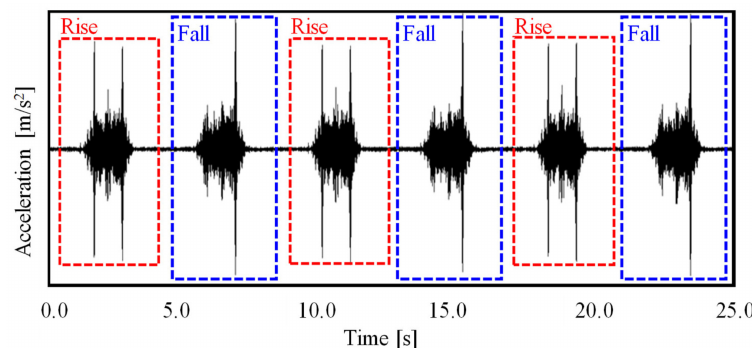
Figure 14. Example of the acceleration waveform for the lifter when rising and descending: These vibration waveforms during the rising and descending phases of operation are slightly di ff erent. In this study, only the vibration waveform for the rising phase was used.